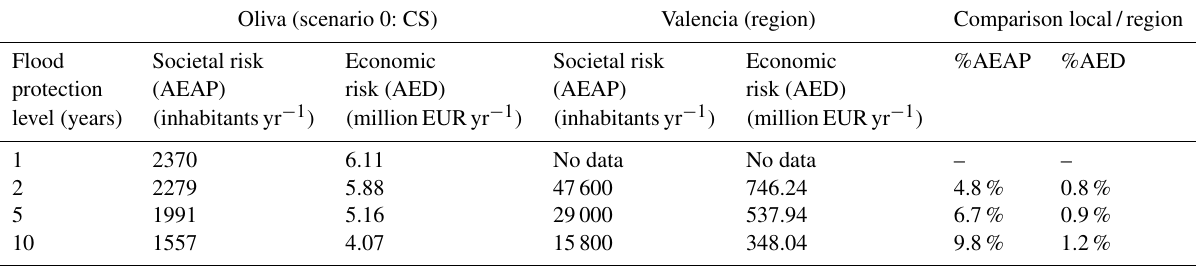
Table 8. Effect of the selection of flood protection